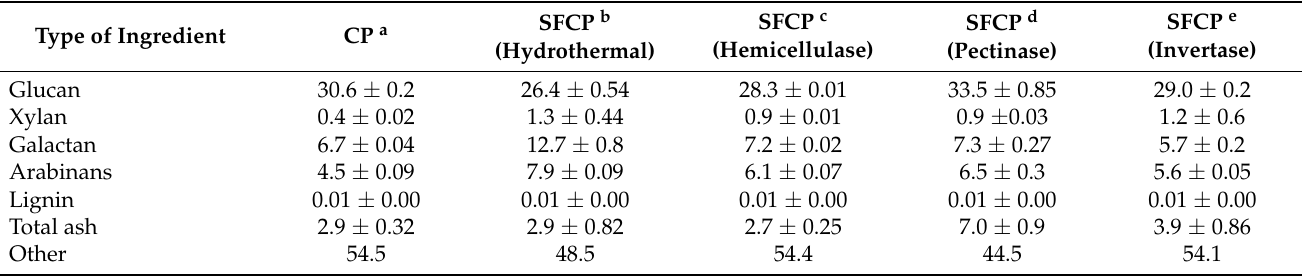
Table 2. The composition of CP and the solid fraction of CP after hydrothermal and enzymatic treatment. All values are given in wt.